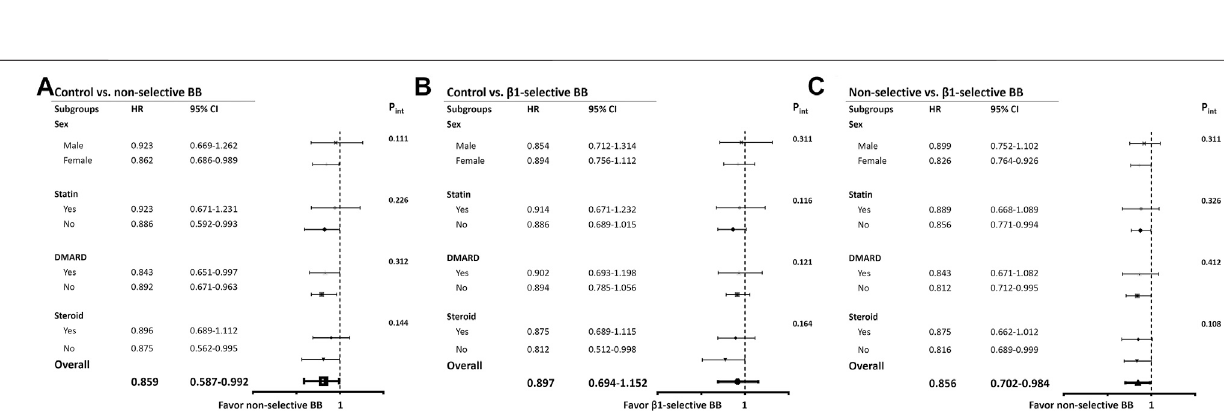
FIGURE 2 | Kaplan – Meier curves showing the overall survival according to the different beta-blocker treatments. (A) Beta-blockers (green line) vs control (red line) (log-rant rest, p (cid:1) 0.034),and (B) Kaplan – Meiercurvesbythree treatment subgroups with pairwise comparisons using thelog-ranktest. *indicated p value < 0.05 when compared with control. Statistically signi fi cant survival differences were noted between non-selective beta-blockers (green line) vs control group (red line) (log-rank test p (cid:1) 0.027) and β 1-selective beta-blockers (blue line) vs control group (log-rank test p (cid:1) 0.036) but not between non-selective versus β 1-selective beta-blockers (log-rank test p (cid:1) 0.142).